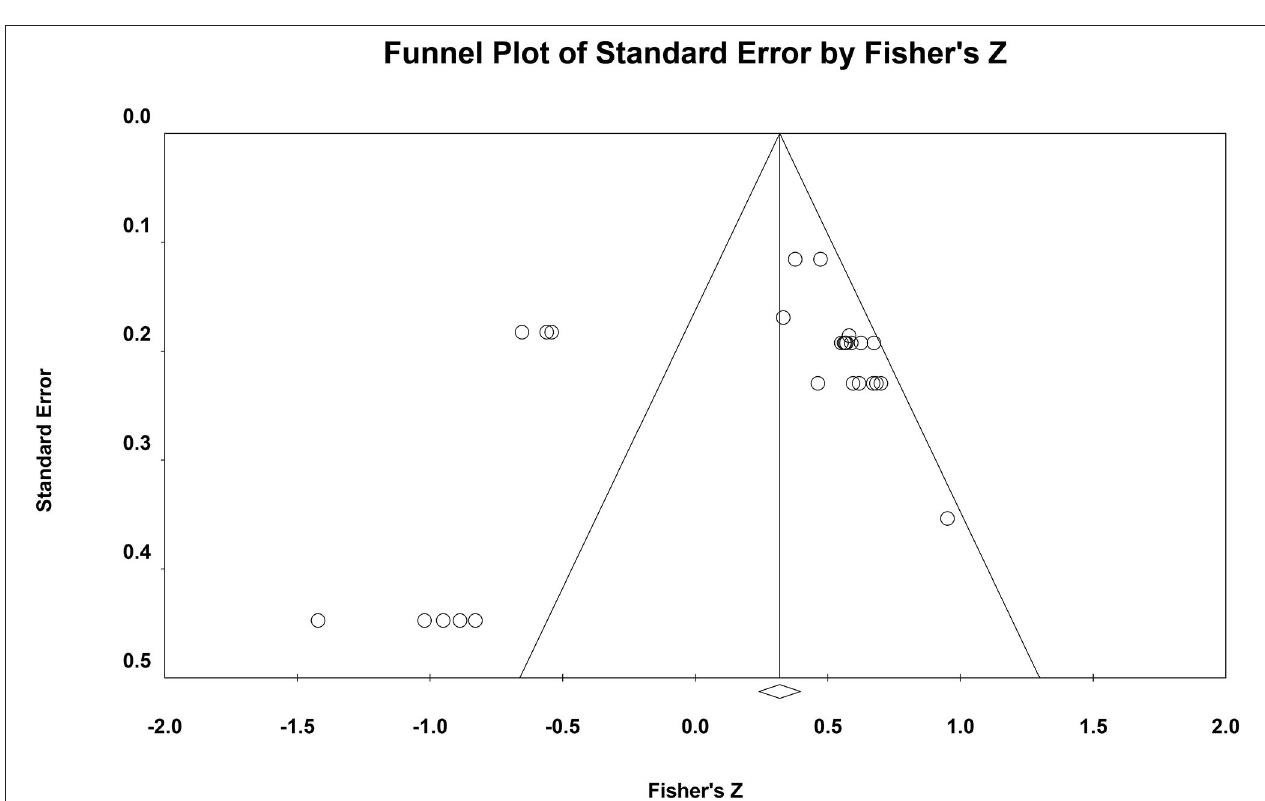
FIGURE 3 | Funnel plot. The vertical axis is the log standard error of the effect size, the horizontal axis is the effect size, the inside of the funnel is the confidence interval, and the central axis is the combined effect